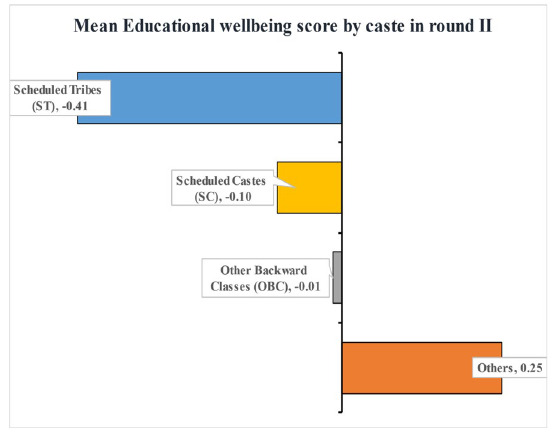
Figure 2. Mean educational wellbeing score of Indian children aged 8–11 years during IHDS round-II by caste groups in India.